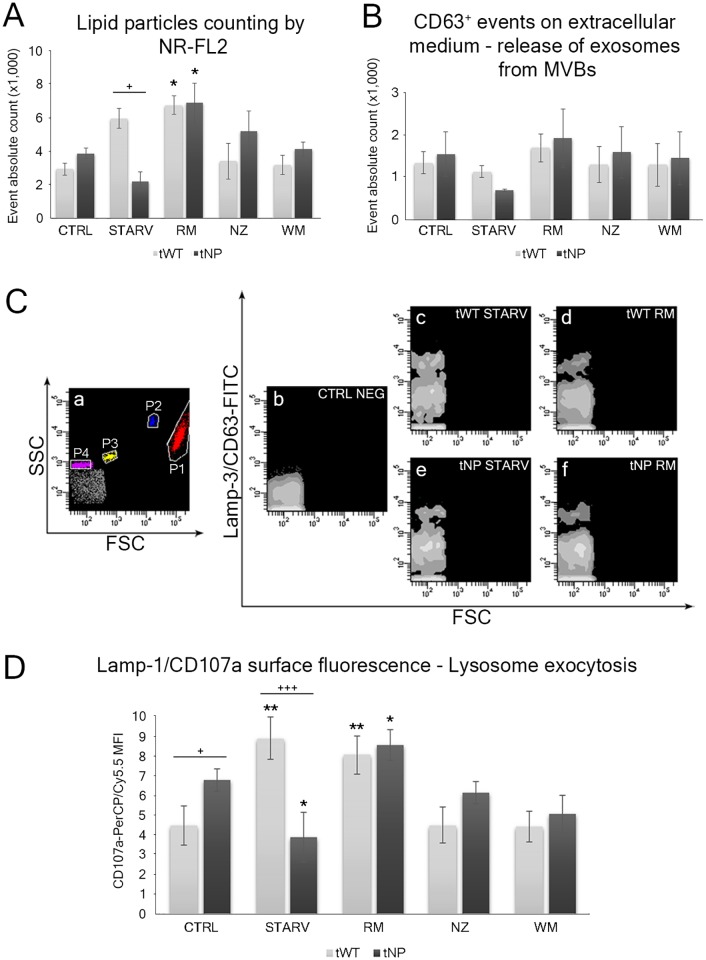
Detection of microvesicles and lipid particles in the extracellular environment and analysis of lysosomal exocytosis.(A) Statistical histogram showing lipid particle counting by NR-FL2 in the extracellular environment for each experimental condition. Each value is expressed as an absolute number ± SD (Results from n ≥ 3 independent experiments); *P < 0.05 vs respective control. Two-way ANOVA with Bonferroni post test revealed a P value < 0.05 (+P < 0.05) between tWT and tNP starved cells. (B) Statistical histogram showing CD63+ events counted in the extracellular environment for each experimental condition. Each value is expressed as an absolute number ± SD (Results from n ≥ 3 independent experiments). (C) Extracellular microparticle/microvesicle detection by FC. (a) Dot plot FSC vs SSC in logarithmic visualization. P1: viable cells; P2: Dako CytoCount counting beads 5.2 μm diameter; P3: beads 1 μm diameter; P4: beads 0.5 μm diameter; (b) Density plot FSC vs FL1 of the negative sample; (c) Density plot FSC vs FL1-CD63 of starved and (d) rapamycin-treated tWT cells. (e) Density plot FSC vs FL1-CD63 of starved and (f) rapamycin-treated tNP cells. (D) Statistical histogram of surface Lamp-1/CD107a detection on fresh cells: MFI values shown are for each experimental condition and from both cell lines. Each value is expressed as a mean ± SD (Results from n ≥ 3 independent experiments); *P < 0.05 and **P < 0.01 vs respective control. Two-way ANOVA with Bonferroni post test revealed a P value < 0.05 (+P < 0.05) between tWT and tNP basal condition and a P value < 0.001 (+++P < 0.001) between tWT and tNP starved cells.